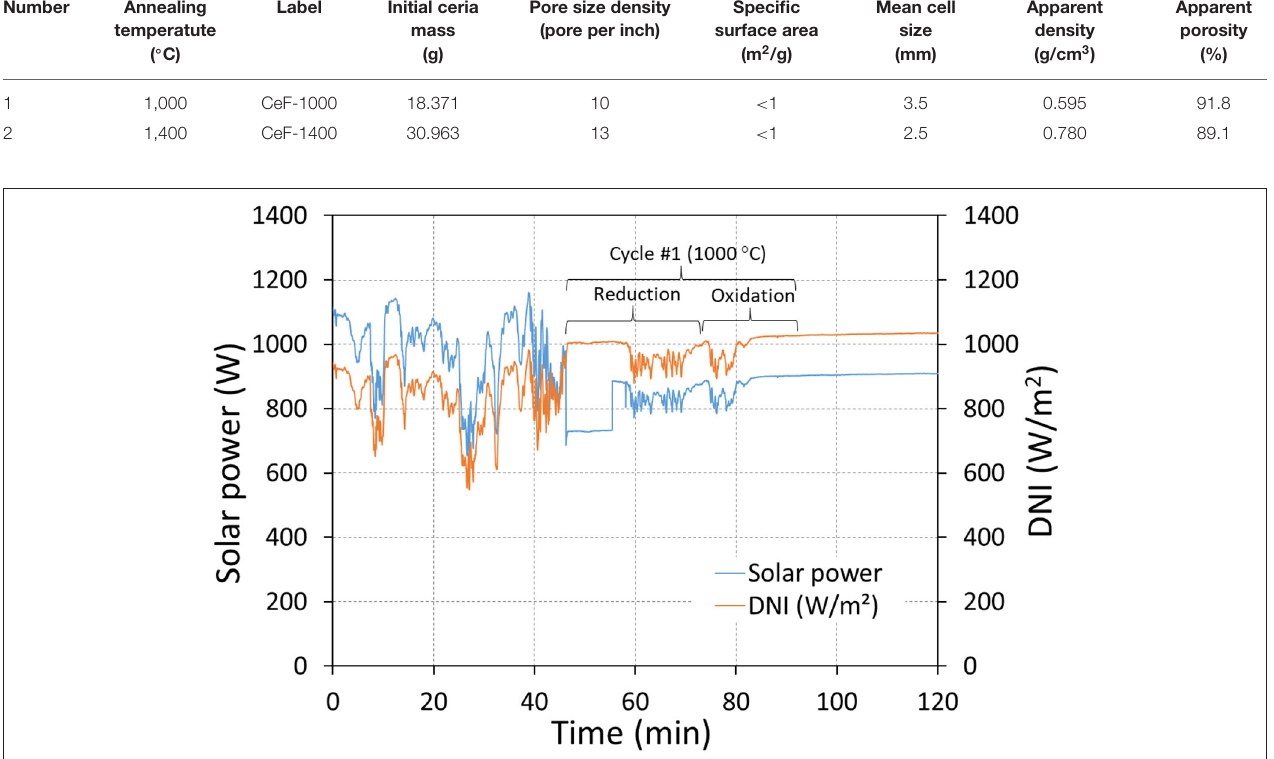
FIGURE 3 | Solar power and direct normal irradiation evolution in the reactor during the heating phase, ceria foam reduction with methane and oxidation with H 2 O (CeF-1400: mass 30.963g, cycle #1).